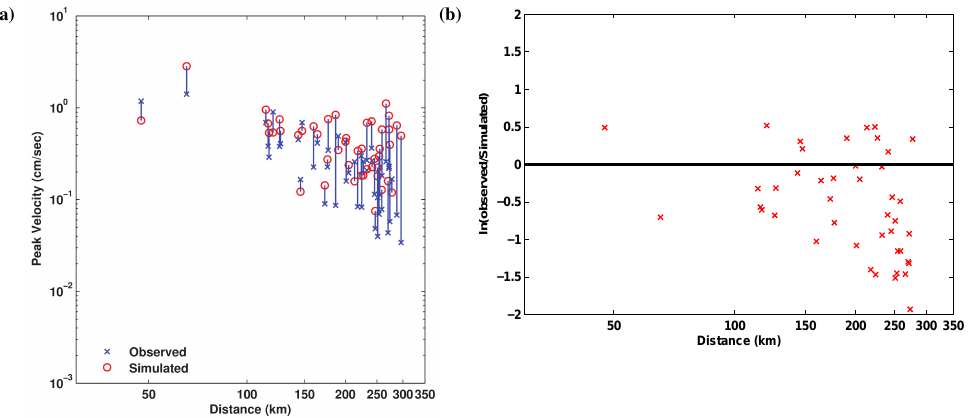
Figure 17. (a) Comparisons of peak ground velocity (PGV) of the simulated and the recorded broadband ground motions as a function of station distance to the hypocenter of the 2004 Parkfield earthquake. (b) Natural log of the residual of simulated and recorded values.